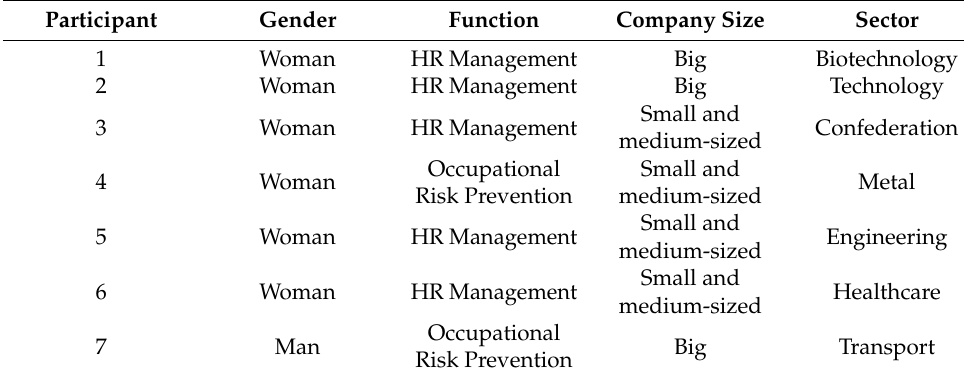
Table 3. Description of the functions of the people in the group of company